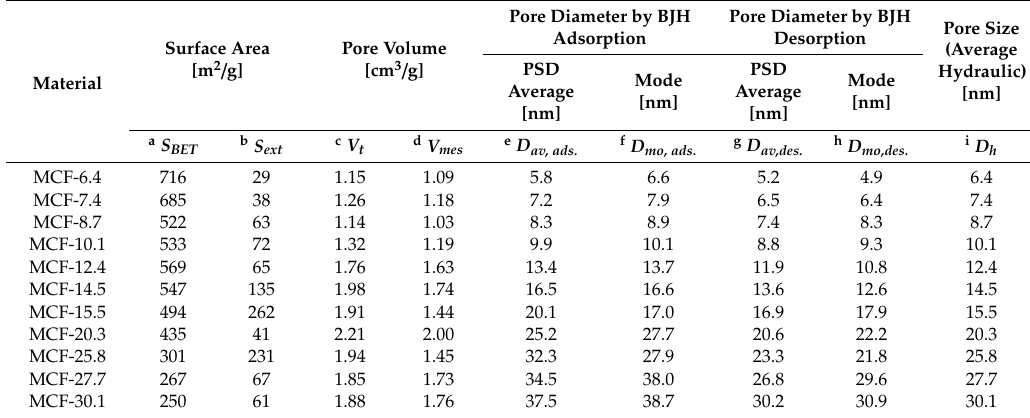
Table 1. Textural parameters of the obtained mesoporous silica